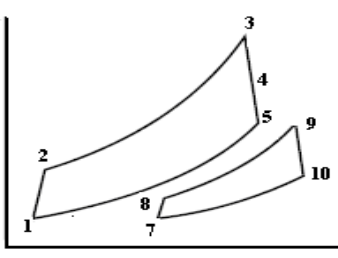
Figure 2. (T-s) diagram of air simple cycle (1, 2, 3, 4 and 5 are the inlet and outlet of each compo- nent of ASC in Figure 1a).